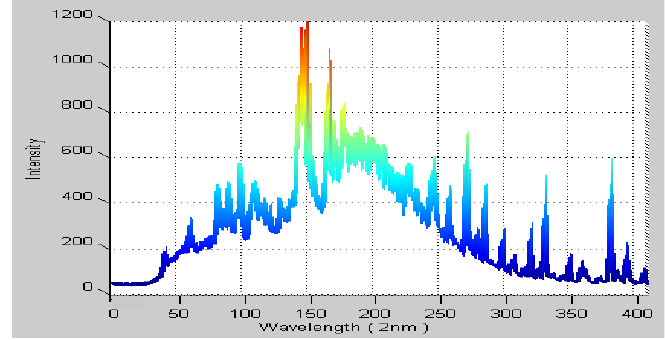
Figure 6. Spectrum data chart in one sample period.